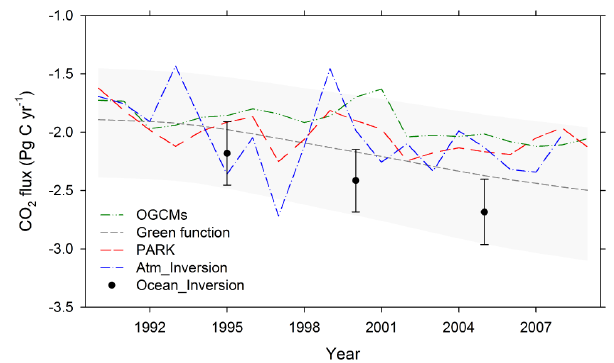
Fig. 8. The 20yr record of annual globally integrated sea–air CO 2 fluxes for the different modeling approaches. For the OBGCMs and atmospheric inverses, the lines are plotted through the annual me- dian